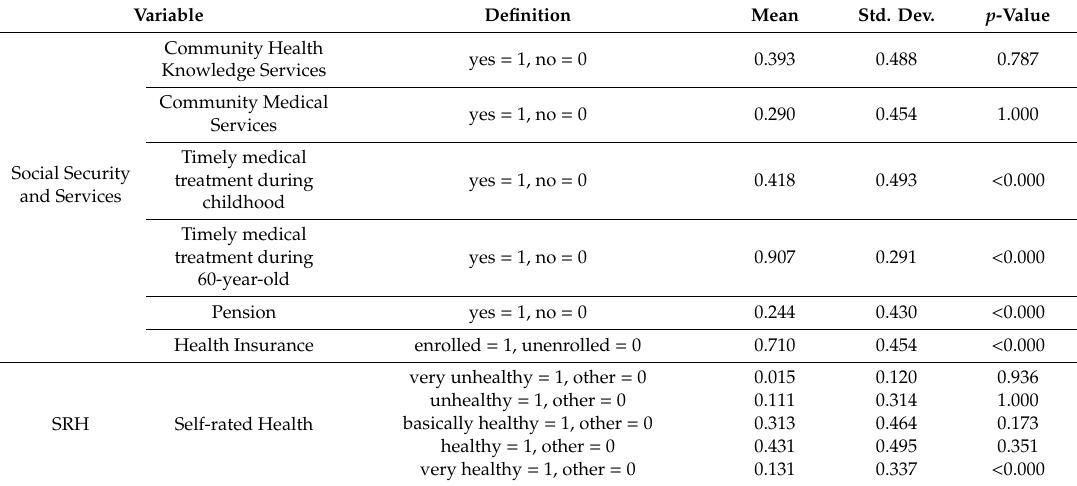
Table 2. Description of influencing factors of the evolution of health